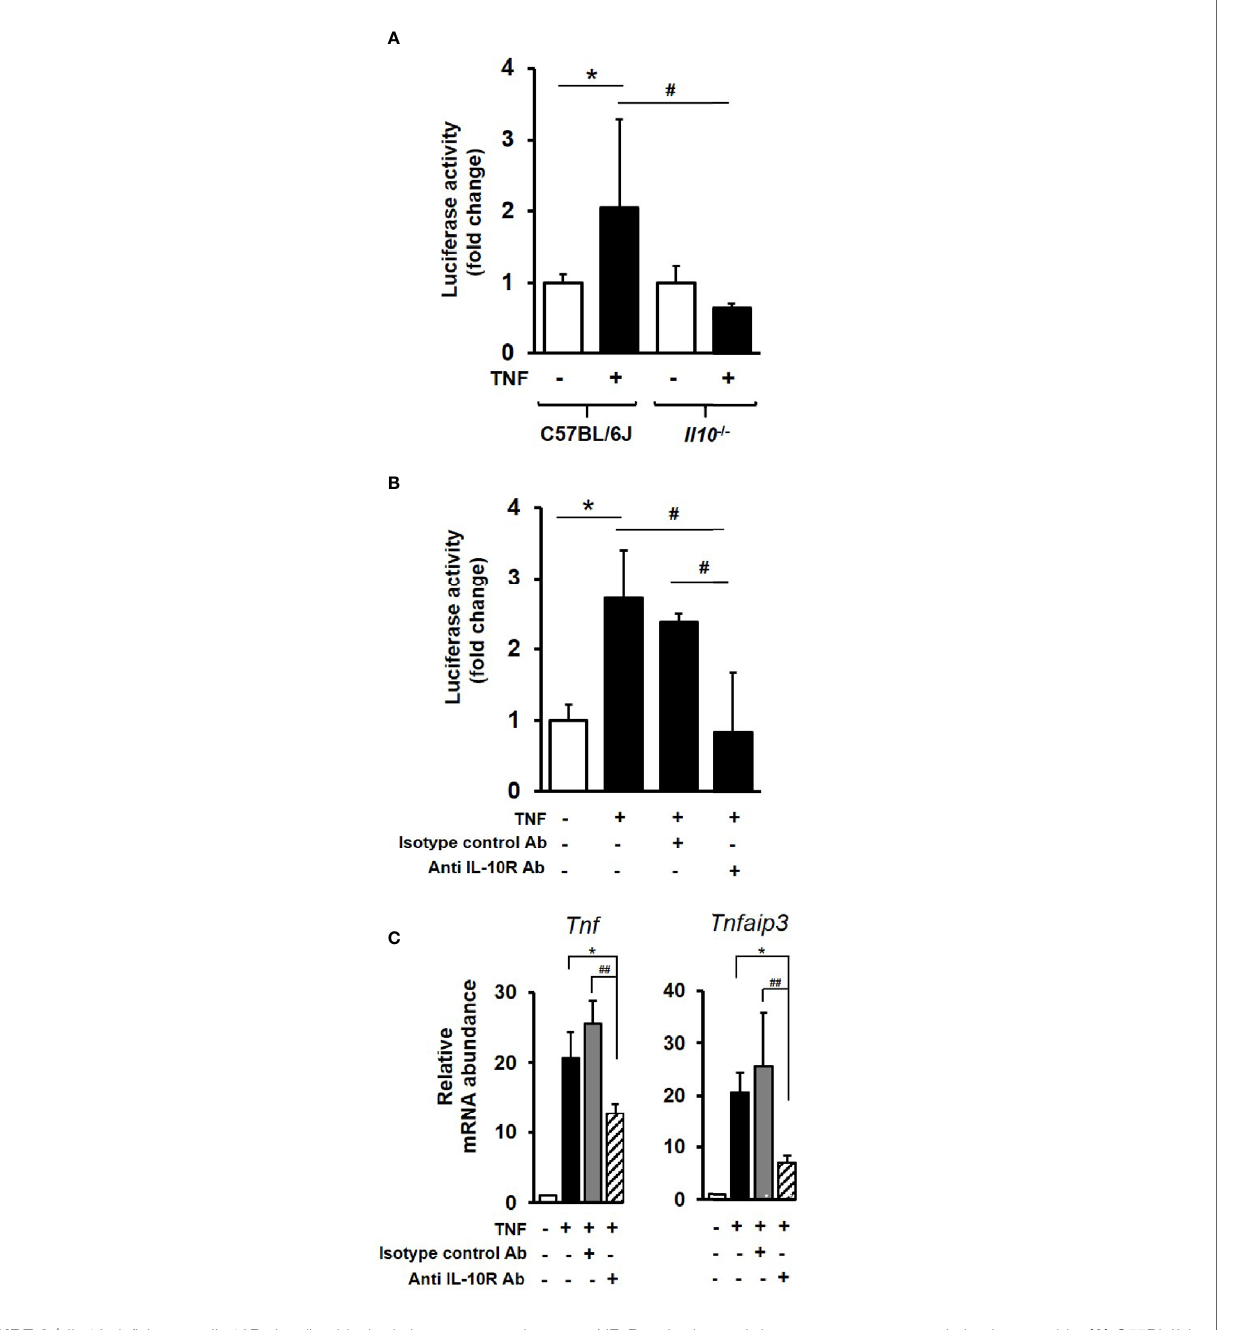
FIGURE 6 | IL-10 de fi ciency or IL-10R signaling blockade impacts on endogenous NF k B activation and downstream gene transcription in enteroids. (A) C57BL/6J and Il10 − / − enteroids were transduced with lentivirus that expresses luciferase under the control of canonical NF k B binding sequence motif. Post transduction (72 h), enteroids were either left unstimulated or stimulated with 100 ng/ml TNF for 3 h. Luminescence was detected using single tube luminometer. (B) Immunoblockade of hTNF.LucBAC enteroids using 1 m g/ml rat anti-mouse IL-10 receptor (IL-10R) antibody (Ab) or rat IgG1, k isotype control, followed by 2 h stimulation with 100 ng/ml TNF. Signi fi cant differences to unstimulated control, * p < 0.05; or stimulated transgenic or immunoblockade, # p < 0.05, Kruskal – Wallis test; N = 3 – 4 mice). (C) Immunoblockade using anti-IL-10R antibody also signi fi cantly suppressed TNF-induced expression at 1 h of two selected early response NF k B target genes Tnf and Tnfaip3 in C57BL/6 enteroids. Signi fi cant differences, * p < 0.05 TNF plus IL-10R antibody compared to enteroids stimulated with TNF alone, and ## p < 0.01 compared to TNF plus isotype control antibody; Kruskal – Wallis test, N = 3 mice. All data is presented as mean ±